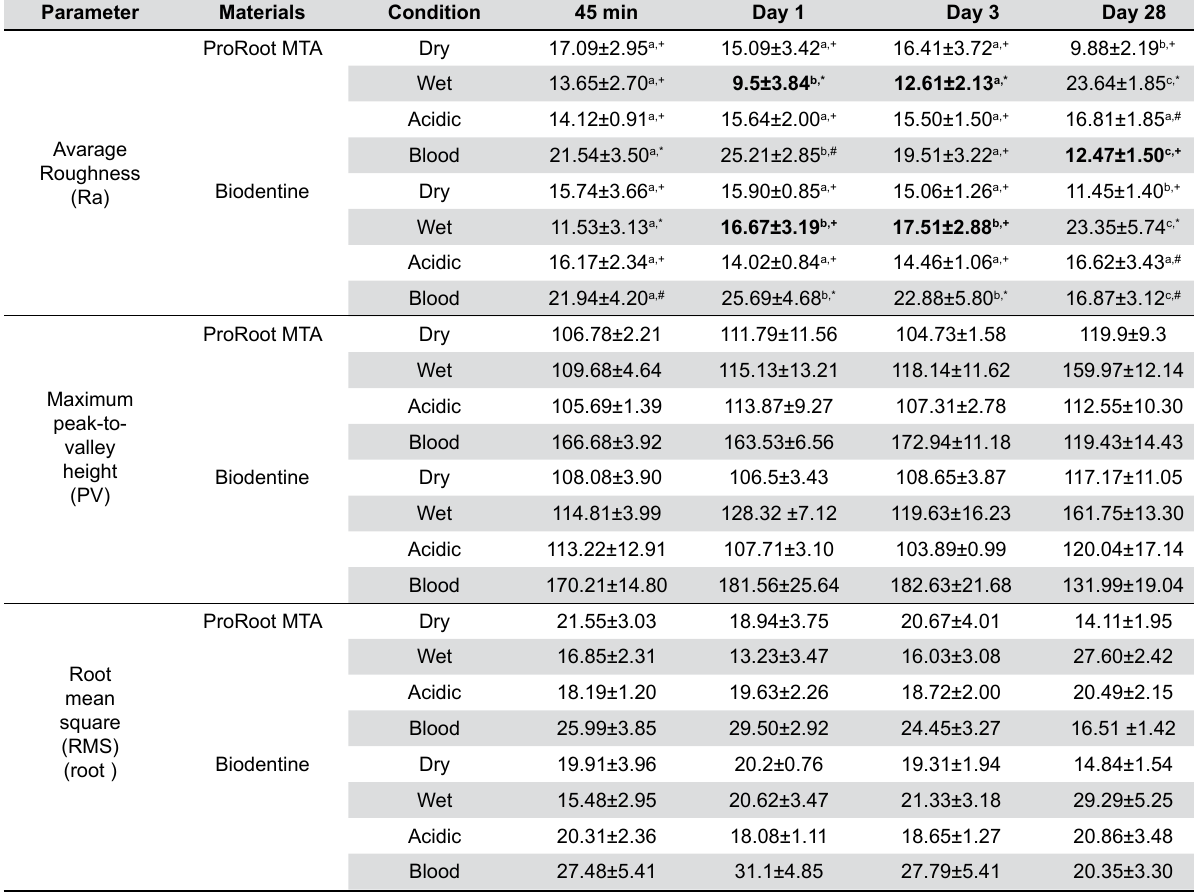
Table 1- Time-dependent surface roughness values (mean ± SD) of ProRoot MTA and Biodentine in different environmental